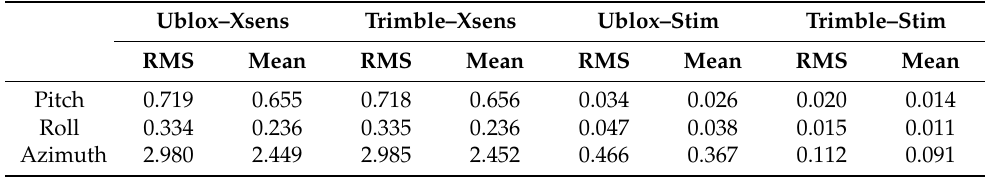
Table 8. RMS error and mean error (deg) of roll, pitch, and azimuth angles—third field